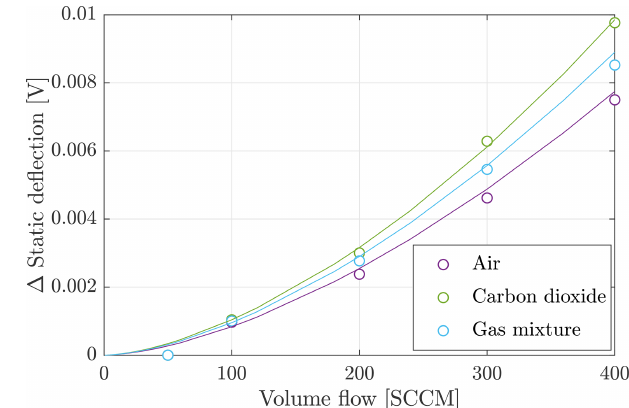
Figure 6. Static deflection as a function of the volume flow for air, carbon dioxide and a gas mixture with a composition 50% to